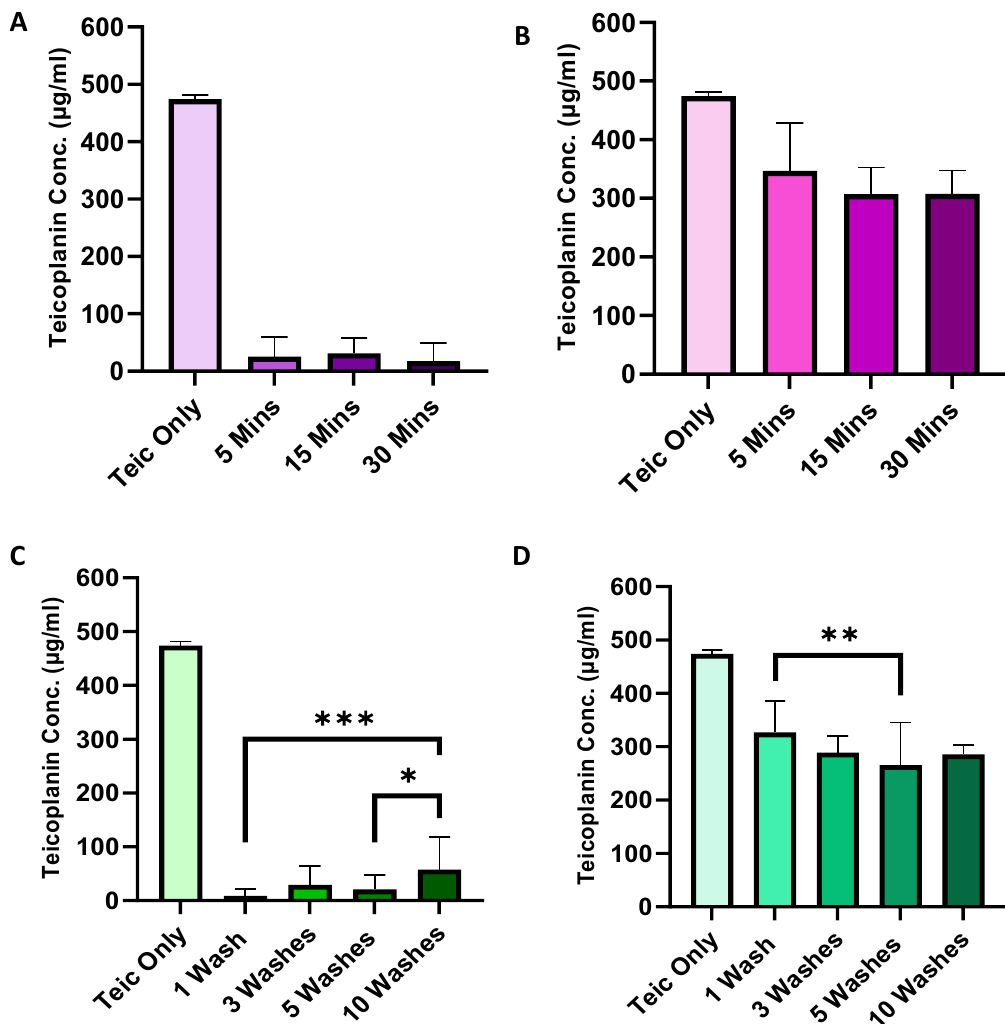
Figure 4. Evidence of a rapid and robust adsorption of Teic to TiO 2 . ( A ) TiO 2 powder (50 mg) was treated with 500 µl of 500 µg/ml Teic in 50 mM HEPES (pH 7.4) and incubated at room temperature for 5, 15 and 30 min. At each time point, samples were centrifuged at 11,300 × g for 2 min and 25 µlof each supernatant was combined to 500 µl of BCA reagent. Samples were incubated for 30 min at 60 °C and the absorbances read at 540 nm against an incubation control (Teic only). Within 5 min there is evidence of antibiotic adsorption to TiO 2 . ( B ) To confirm Teic-TiO 2 adsorption, the supernatant was decanted, and samples were washed twice by centrifugation and resuspended in 500 µl HEPES buffer. A 25 µl aliquot of each powder sample was added to 500 µl of BCA reagent and incubated for 30 min at 60 °C. Once incubated, powder samples were centrifuged at 11,300 × g for 2 min and 100 µl of each sample were transferred to a 96-well plate and measured in the same manner as above. ( C ) TiO 2 powder (50 mg) were similarly treated with 500 µl of Teic and incubated at room temperature for 2 h. Once incubated samples were centrifuged at 11,300 × g for 2 min, the supernatants were discarded, and the pellets were washed up to 10 times with HEPES buffer (500 µl). Aliquots (25 µl) of each wash were subject to the BCA assay to ascertain antibiotic leaching. ( D )After each set of washes the remaining TiO 2 pellets were resuspended in fresh buffer (500 µl) and samples containing the powder (25 µl) taken for the BCA assay. All data (mean ± SD; N = 20) represent pooled quadruplicate runs from 5 independent